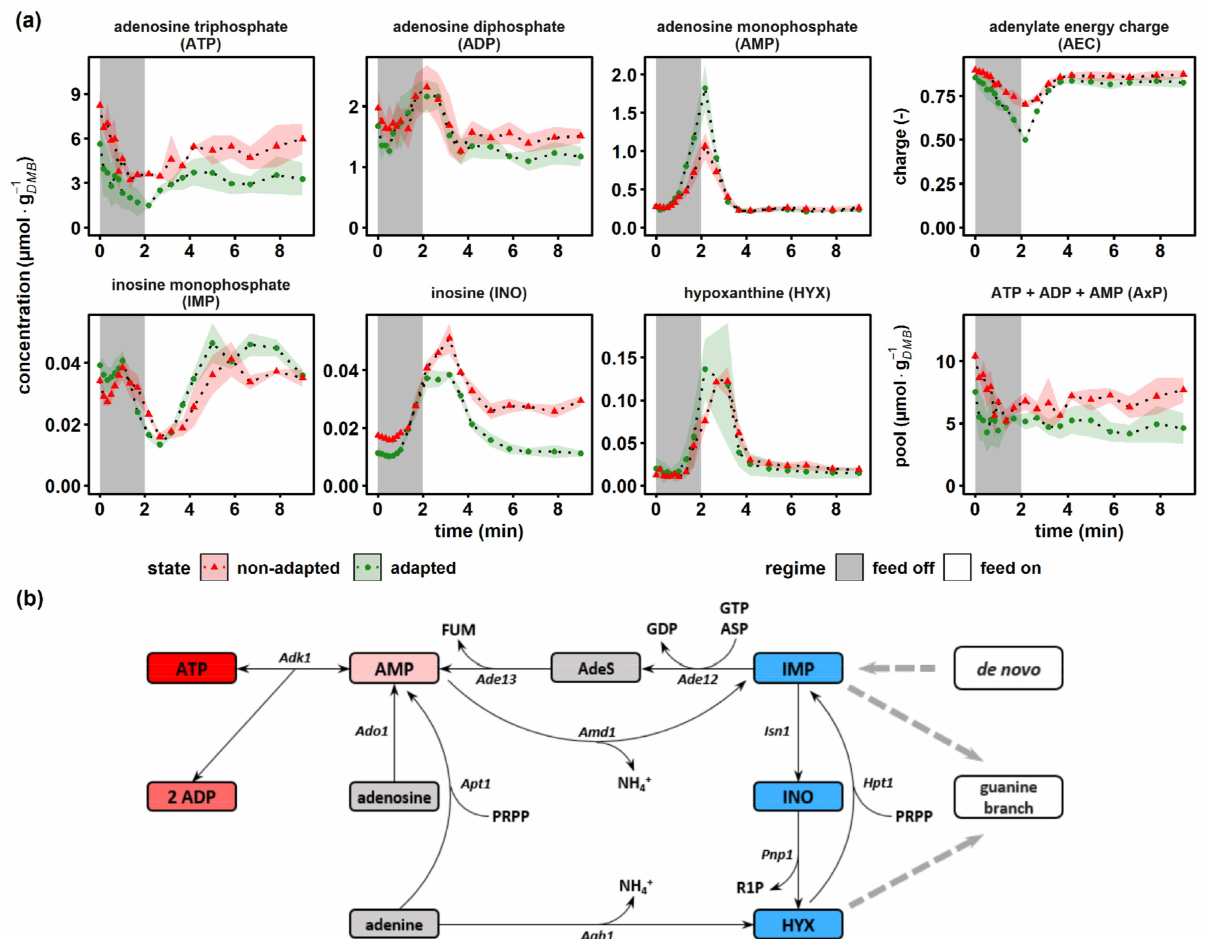
Figure 6. Dynamics of energy carriers and intermediates of the purine salvage pathway. ( a ) The non-adapted response (red) indicates dynamics following a single transition into a starvation scenario (“feed off” phase) and the adapted response (green) was sampled from representative 9 min cycles during steady-state DS. Time point 0 min of the non-adapted response was equal to steady-state RS. The adenylate energy charge was calculated according to [72]. All values indicate means ± standard deviation of three biological replicates. ( b ) Schematic representation of the adenylate kinase sys- tem attached to the purine salvage pathway, reproduced from [73,74]. Aah1 , adenine deaminase; Ade12 , adenylosuccinate synthase; Ade13 , adenylosuccinate lyase; AdeS, adenylosuccinate; Adk1 , adenylate kinase; Ado1 , adenosine kinase; Amd1 , AMP deaminase; Apt1 , adenine phosphoribosyl transferase; ASP, aspartate; FUM, fumarate; Hpt1 , hypoxanthine-guanine phosphoribosyl transferase; Isn1 , IMP-specific 50-nucleotidase; Pnp1 , purine nucleoside phosphorylase; PRPP, phosphoribosyl pyrophosphate; R1P,